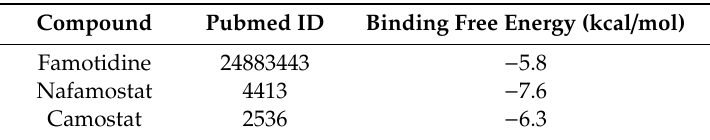
Table 4. Binding free energies calculated for famotidine and other protease inhibitors upon docking to human host protease